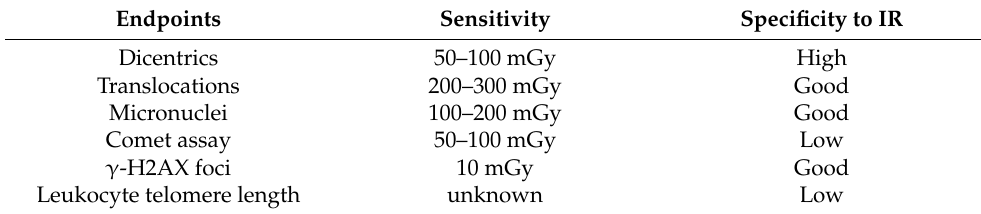
Table 4. Detection limit dose and specificity for